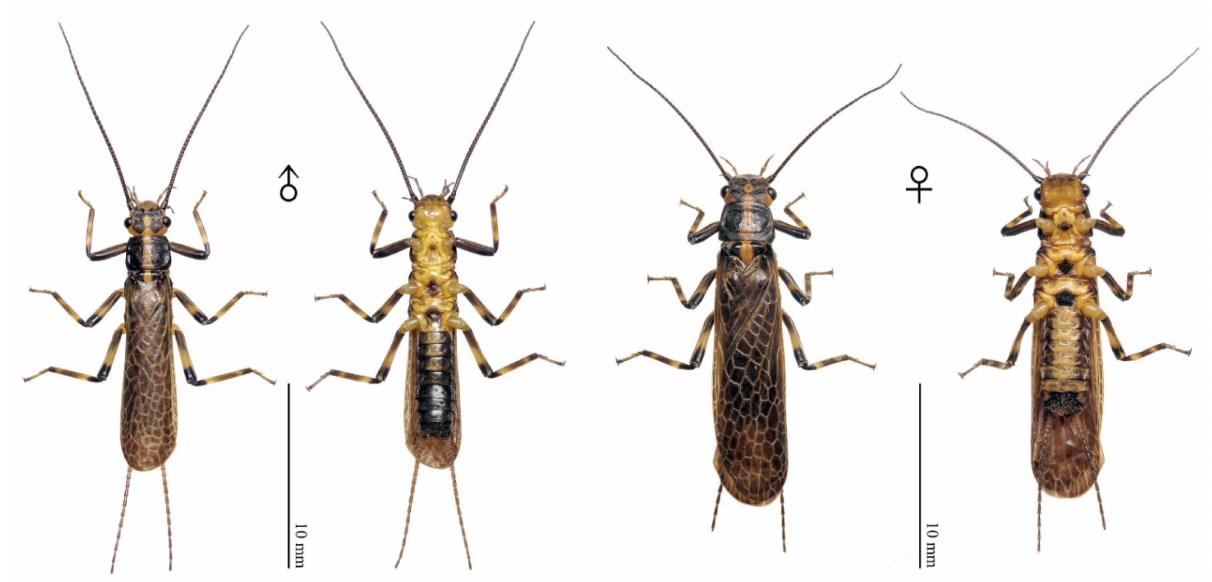
Figure 8. Filchneria zhouchangfai newly recorded from Anhui, male and female habitus. Supplemental description: The front half of the paraproct is eversible and becomes swollen and hard when injected with bodily fluids (Figure 9). The aedeagus is a membra‑ nous, complex tridimensional structure; it is translucent, without sclerite or spines, and smooth on the surface. The basal lobe and anterior lobe are inflated; the submedian is constricted. The basal lobe has a pair of short tuberculous lateral arms. The anterior lobe has a pair of large triangular lateral arms extending outwards; the dorsal part is swelling and hollowed ventrally as a hood‑like cavity. A short subulate process protrudes from the cavity, with a sparse brown hair brush near the base (Figure 10).